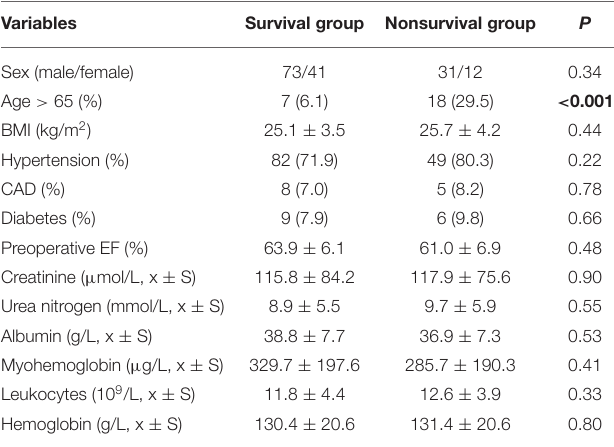
TABLE 1 | Baseline characteristics in the survival and nonsurvival groups.